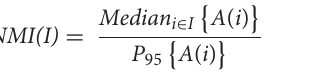
Frontiers in Bioengineering and Biotechnology |